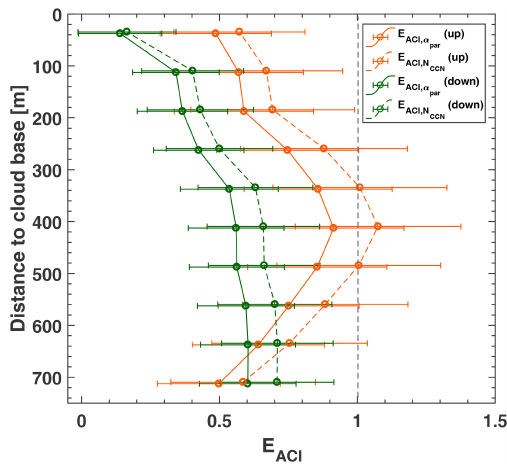
Figure 12. ACI efficiency parameter E ACI (see Table 1 and Sect. 6 in Part 1 for detailed explanations) as a function of N d and α par (solid curves, E ACI ,α ) and as a function of N d and N CCN (dashed par curve, E ACI , N ), separated for updraft periods (orange) and CCN downdraft periods (green). Different values of aerosol proxies α par and N CCN for different layers (with 75m vertical depth and increas- ing distance from the cloud base towards lower heights) are consid- ered in the calculations of the four E ACI parameters (as explained in Fig.11). The ACI efficiencies are assigned to the center heights of these 75m deep aerosol layers for which the aerosol proxies were determined. E ACI values around 400m below the cloud base are obviously not affected by aerosol water-uptake effects which tend to widely smooth out a well-defined and strong correlation between aerosol proxy and cloud droplet number concentration. Error bars indicate the uncertainty in the determination of the slopes of the linear regression